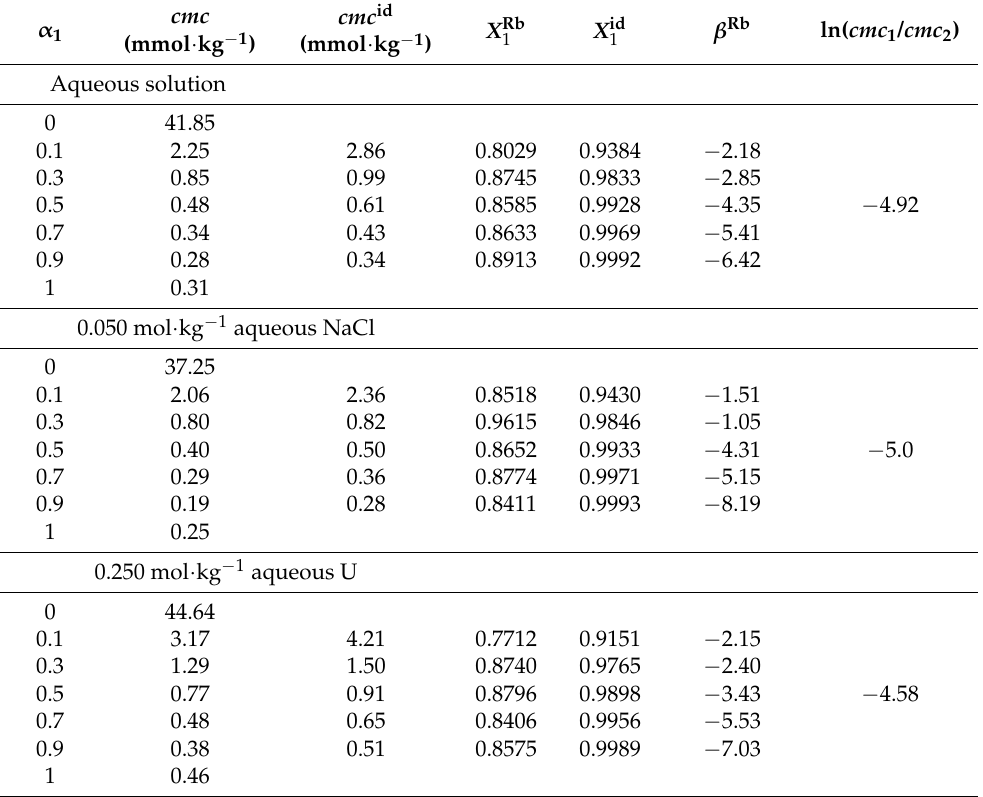
Table 1. Various physicochemical parameters for IMP+TX-100 mixture in several solvents at 298 K a